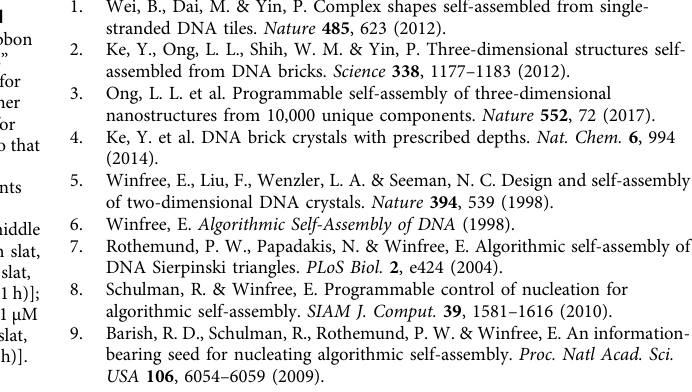
[Supplementary Fig. 38B: (1 µM each slat, 16 mM MgCl 2 , 4 – 49 °C, 6h) → (1 µM each slat, 16mM MgCl 2 , 50 °C, 10 h)]; [Supplementary Fig. 39: (1µM each slat, 16mM MgCl2, 4 – 44.3°C, 6h) → (1 µM each slat, 16 mM MgCl 2 , 50 °C, 17 h)]. For Fig. 3I middle and rightmost, buffer containing additional MgCl 2